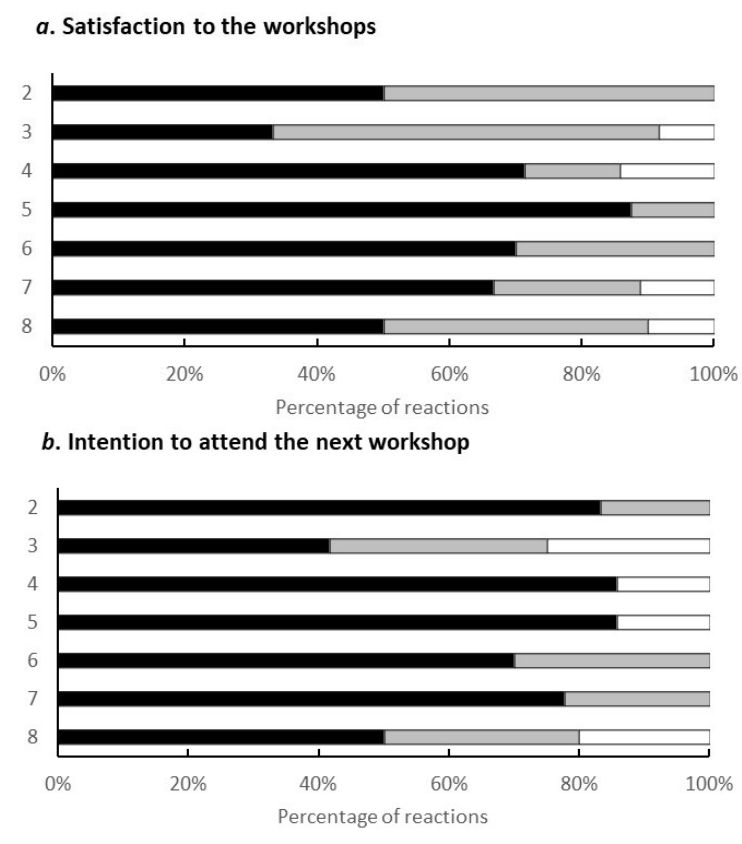
Figure A1. The vertical axis represents the number of times the workshop was held, and the horizontal axis represents the breakdown of respondents for each workshop. Black, grey and white bars exhibit 'strongly agree', 'agree' and 'neither’, respectively, to: ( a ), Satisfaction to the programme; ( b ), Intention to attend the next workshop; ( c ), Willingness to recommend the programme to others. Free answers Q. I would like to ask you about the intestinal environment test. Please tell us why you would like, or not like, to take the test. Questionnaire in the seventh workshop; all respondents answered that they would like to take the test.